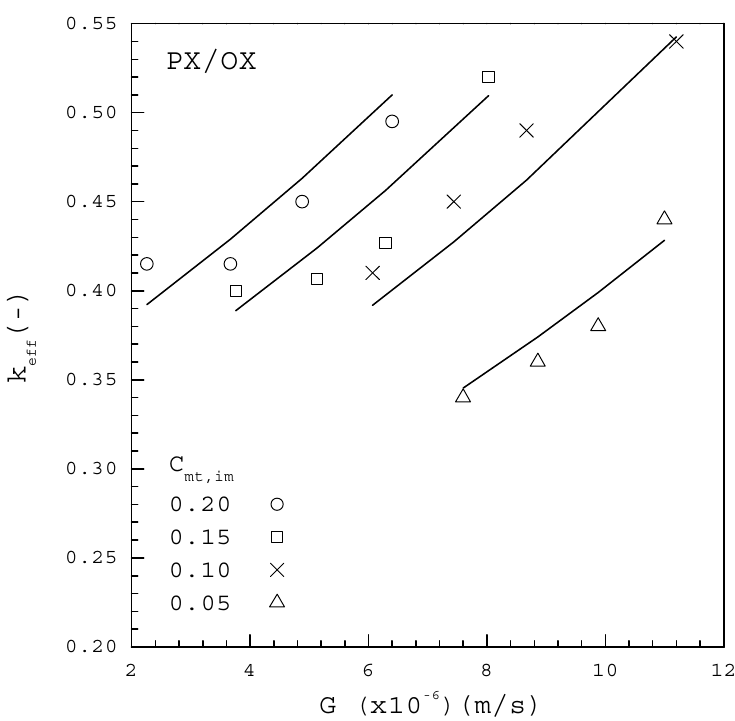
Figure 7. The dependence of k e ff on G from the PX / OX mixture for various C mt,im Figure 7. The dependence of k (cid:2915)(cid:2916)(cid:2916) on G from the PX/OX mixture for various C (cid:2923)(cid:2930),(cid:2919)(cid:2923) . Figure 7. The dependence of k (cid:2915)(cid:2916)(cid:2916) on G from the PX/OX mixture for various C (cid:2923)(cid:2930),(cid:2919)(cid:2923) .